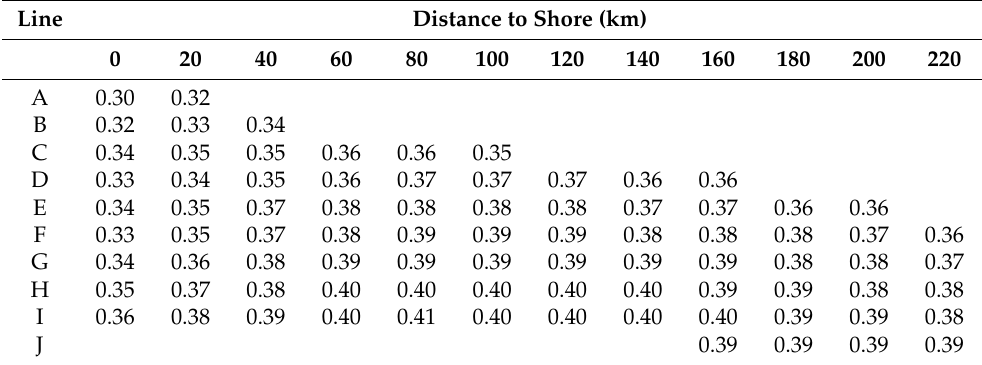
Table 4. Distribution of the SV values indicated for the ERA5 data ( U 100 ), considering the time interval